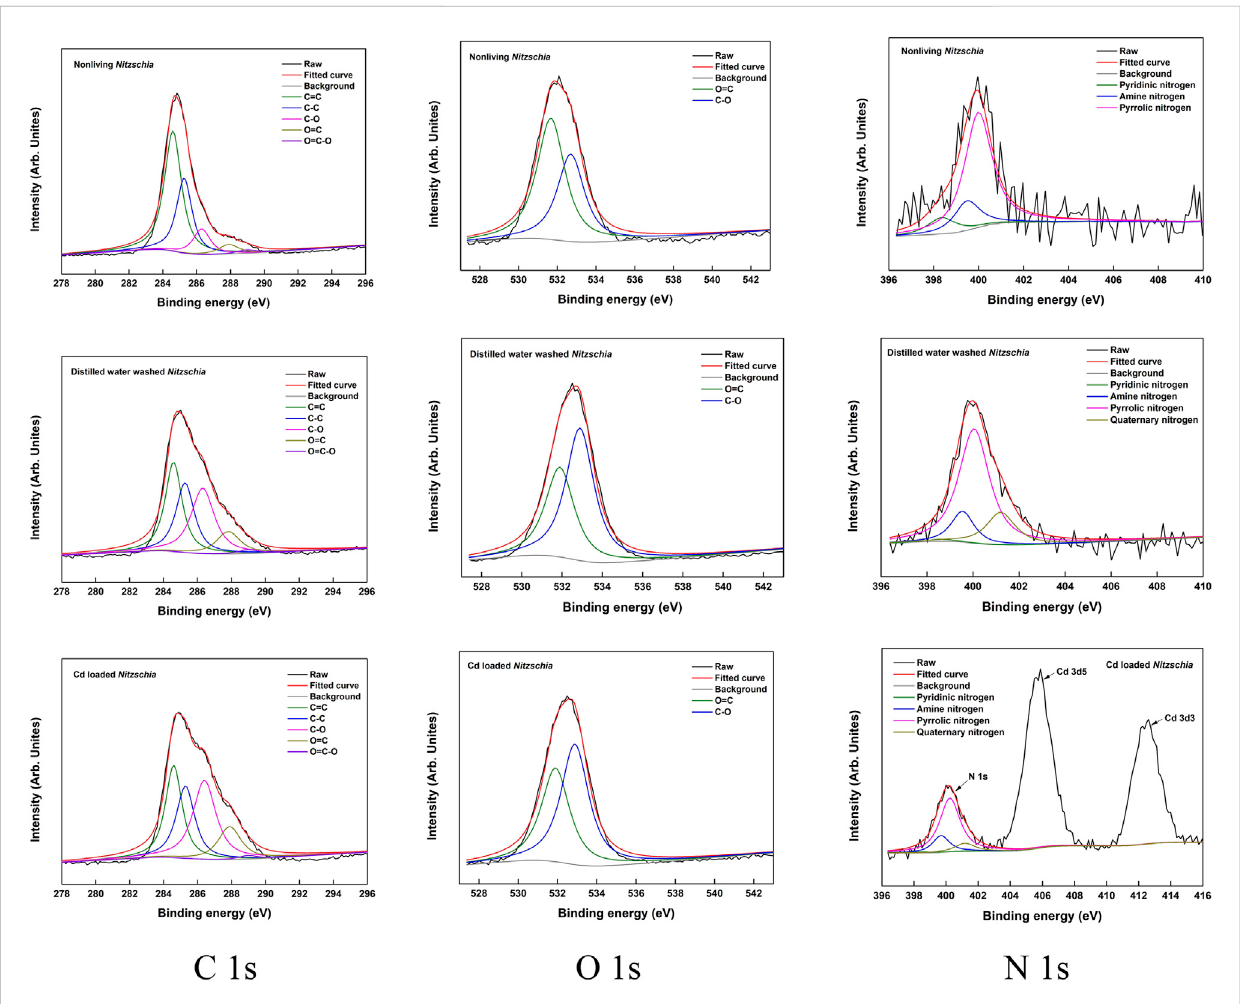
FIGURE 7 XPS spectra of C 1s, O 1s, and N 1s of non-living Nitzschia , distilled water-washed Nitzschia , and Cd-loaded Nitzschia